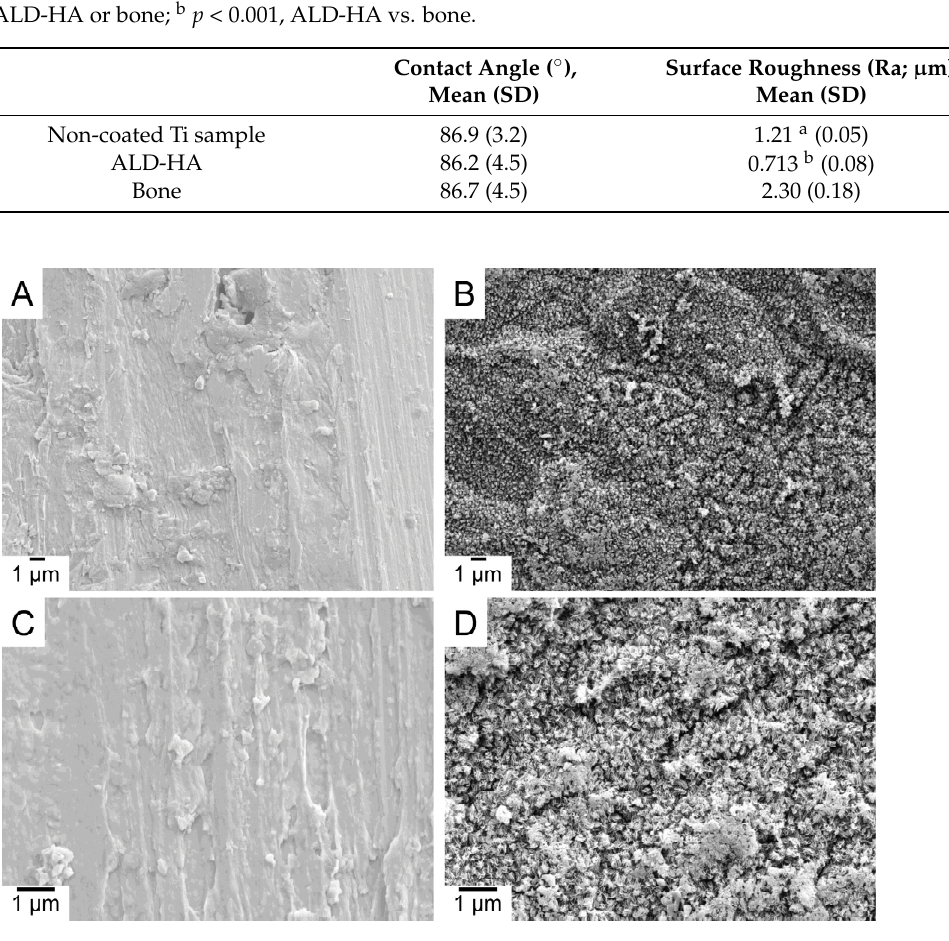
Figure 1. FESEM images of non-coated Ti sample ( A , C ) and ALD-HA ( B , D ). HA crystals appear on ALD-HA, whereas the non-coated Ti sample is devoid of them. Magnification 4000 × ( A , B ) and 10,000 × ( C , D